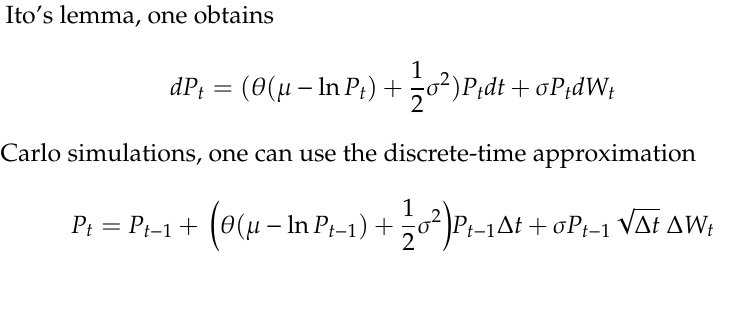
Figure 1. Average price of residential properties (€ per square meter). (Mapchart.net 2020).